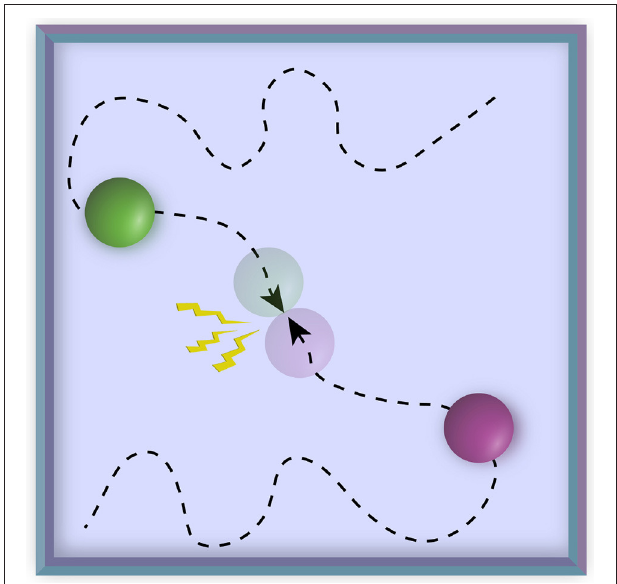
FIGURE 1 | Experimental paradigm. To vary threat level dynamically, two circles moved around on the screen with some degree of randomness, sometimes approaching each other, other times retreating from each other. When they collided with each other, an unpleasant mild electric shock was